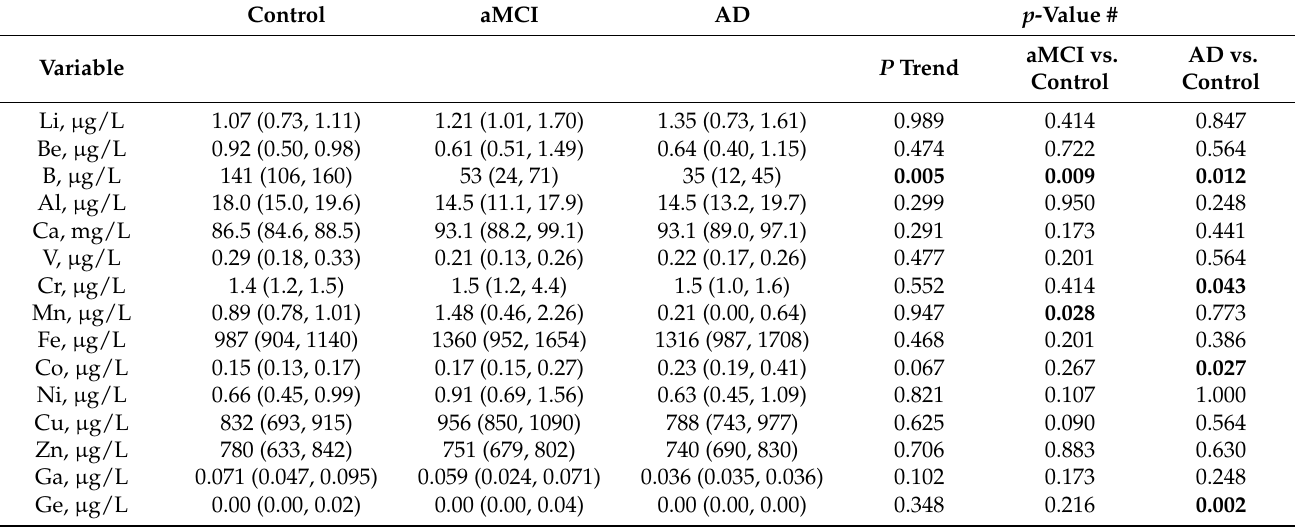
Table 2. Trace metals of the enrolled participants according to disease group a